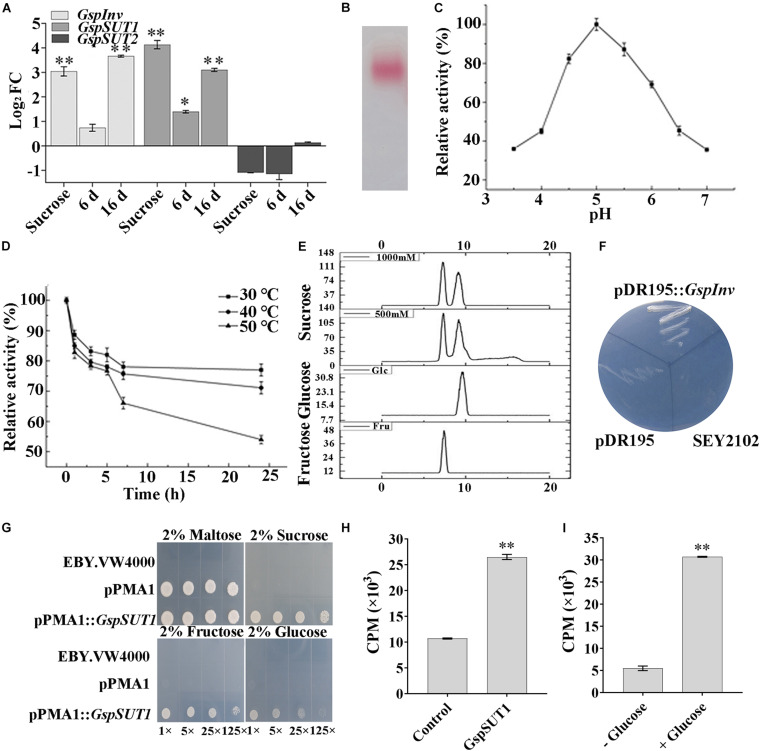
Activity and function determination of GspInv and GspSUT1.(A) Fold changes of w5 invertase gene (GspInv) and sucrose transporter genes (GsSUT1 and GsSUT2) after 24 h cultivation in the presence of sucrose or after co-cultivated with M. truncatula at 6 dpi and 16 dpi. The control group was w5 cultured on medium without carbon source. Values are the means ± standard (n = 9). (B) Native-PAGE of purified GspInv. (C,D) Effects of pH and temperature on activity of GspInv. (E) Analysis of sugar products using 1000 mM and 500 mM sucrose as the substrate to test transglycosidase activity. (F) Heterologous expression of GspInv in invertase-deficient yeast S. cerevisiae strain SEY2102 on synthetic medium with sucrose as the sole carbon source. (G) Complementation of the yeast hexose transport-defective strain EBY.VW4000 with GspSUT1. The yeast cells were grown on SD media containing different sugars as sole carbon source at 30°C for 3 days. In each image, the yeast strain was diluted to an OD600 of 0.2 and then ×1, ×5, ×25, and ×125 diluted with sterile water. (H) Sucrose uptake experiment using 3H-sucrose as the substrate. (I) GspSUT1 is activated in the presence of the metabolizable carbon source glucose in SEY2102. *p < 0.05; **p < 0.01.